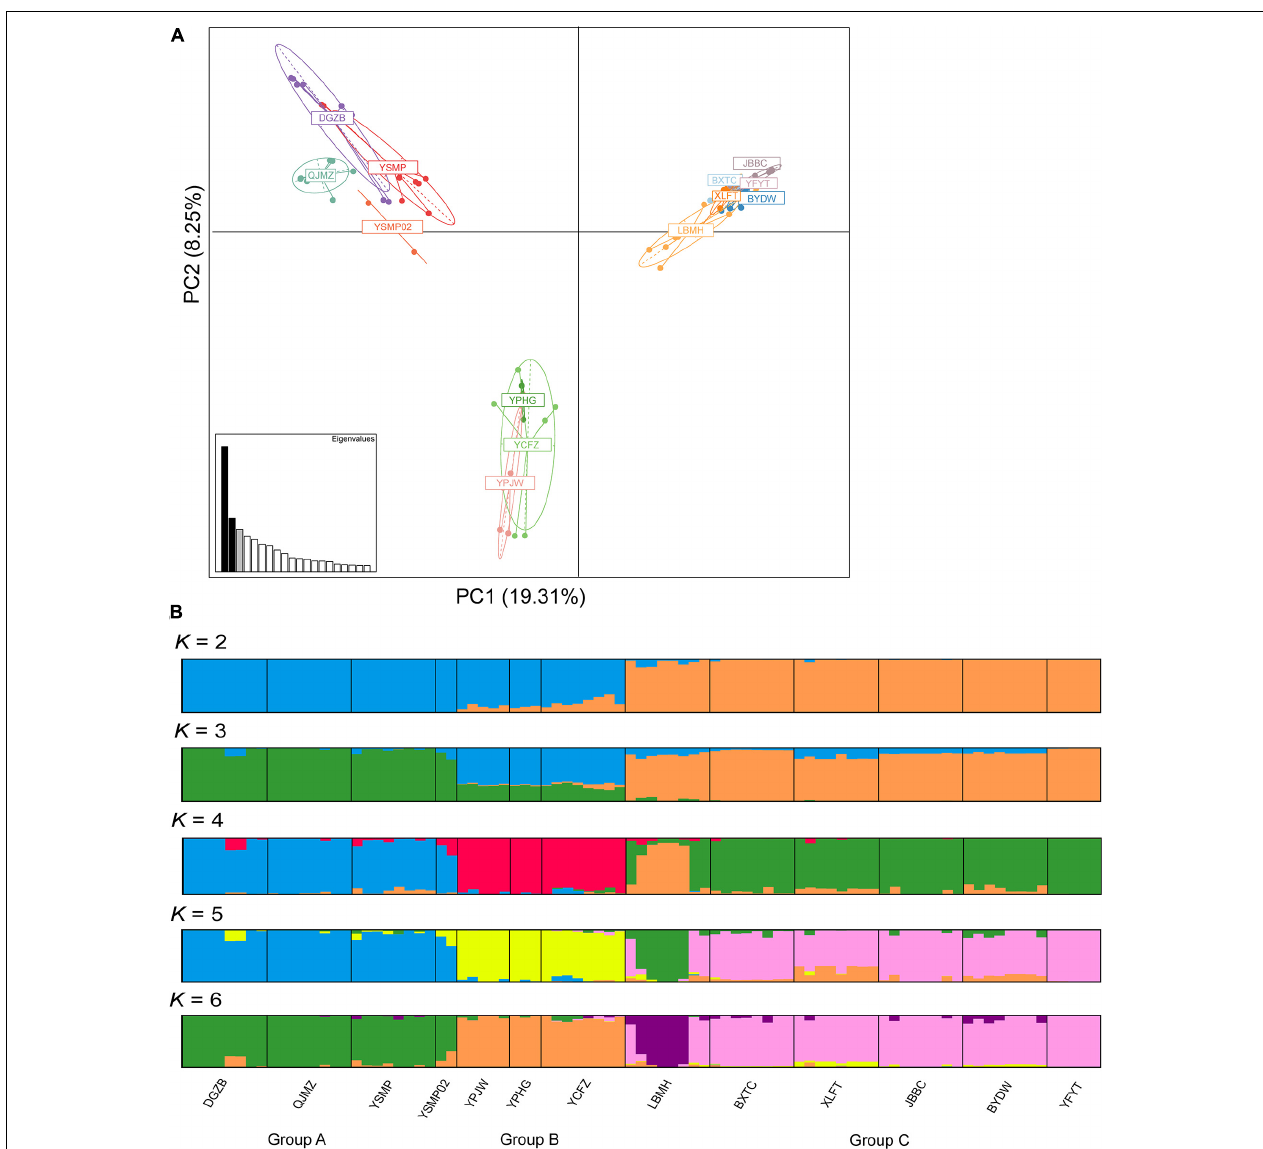
FIGURE 2 | Genetic structure of Amorphophallus albus germplasms investigated by principal component analysis (A) and STRUCTURE (B) .